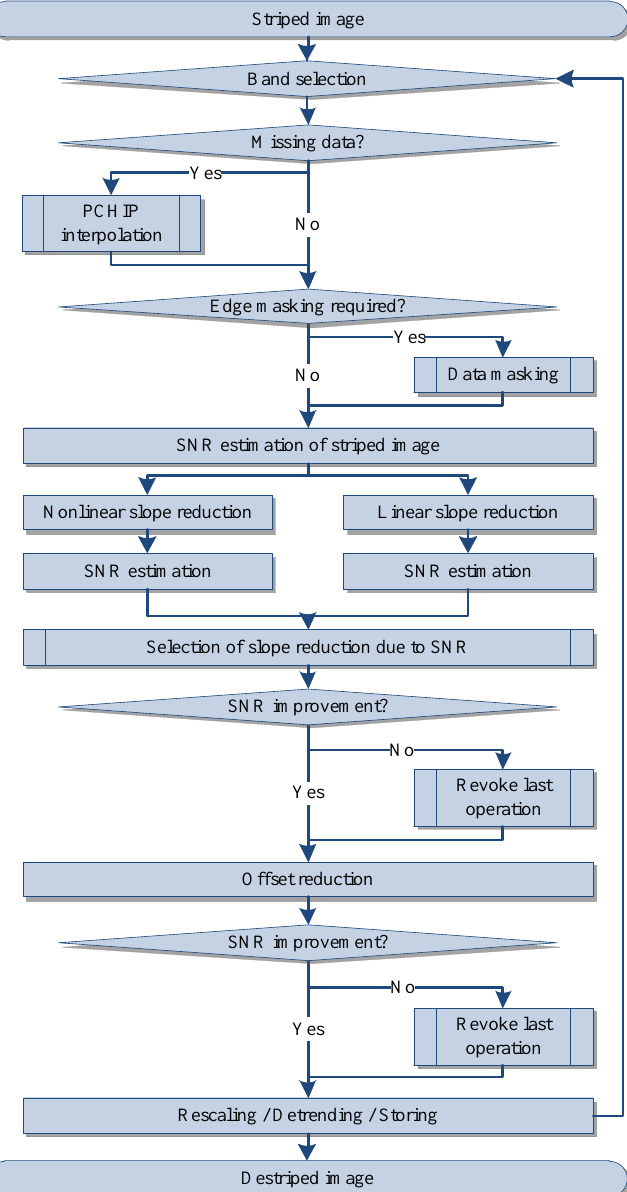
Figure 4. The destriping processing chain of the ‘ROM ’